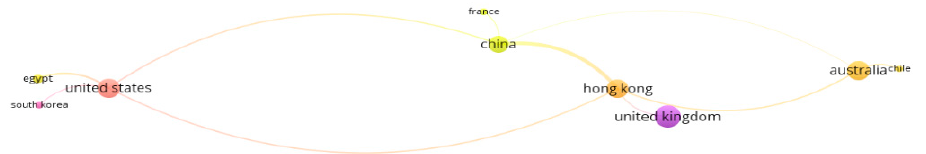
Figure 5. A collaborative network of countries .